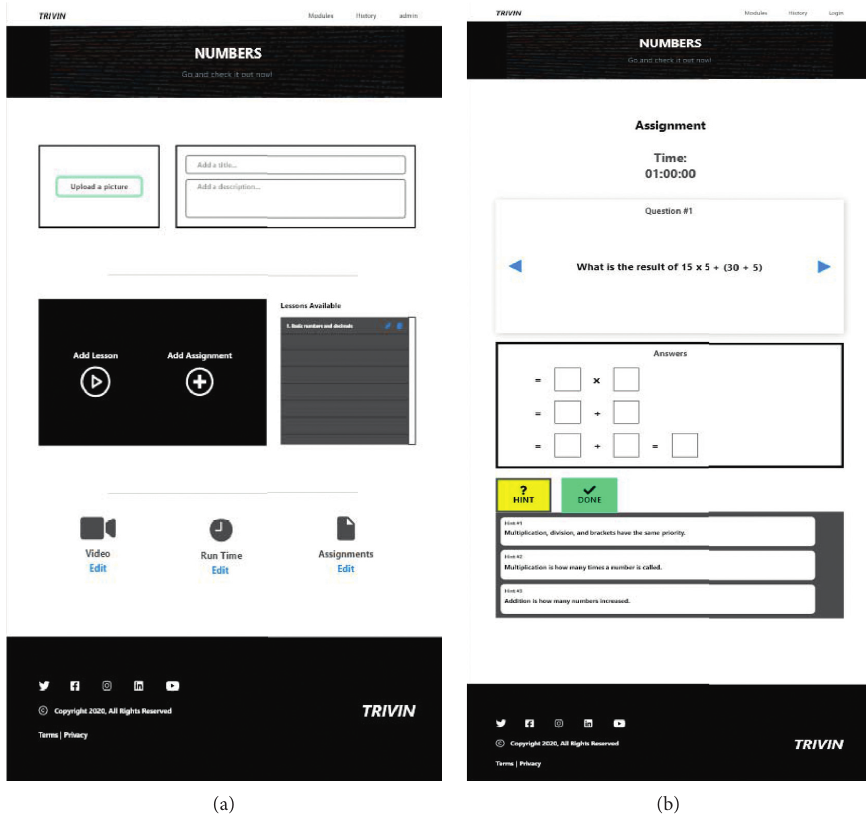
Figure 6: (a) Module detail page for admin UI and (b) module detail assignment page